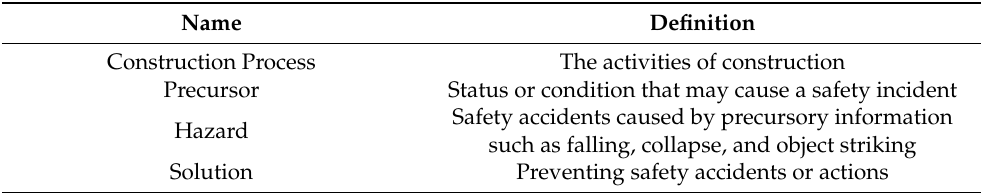
Table 1. Category concept definition.